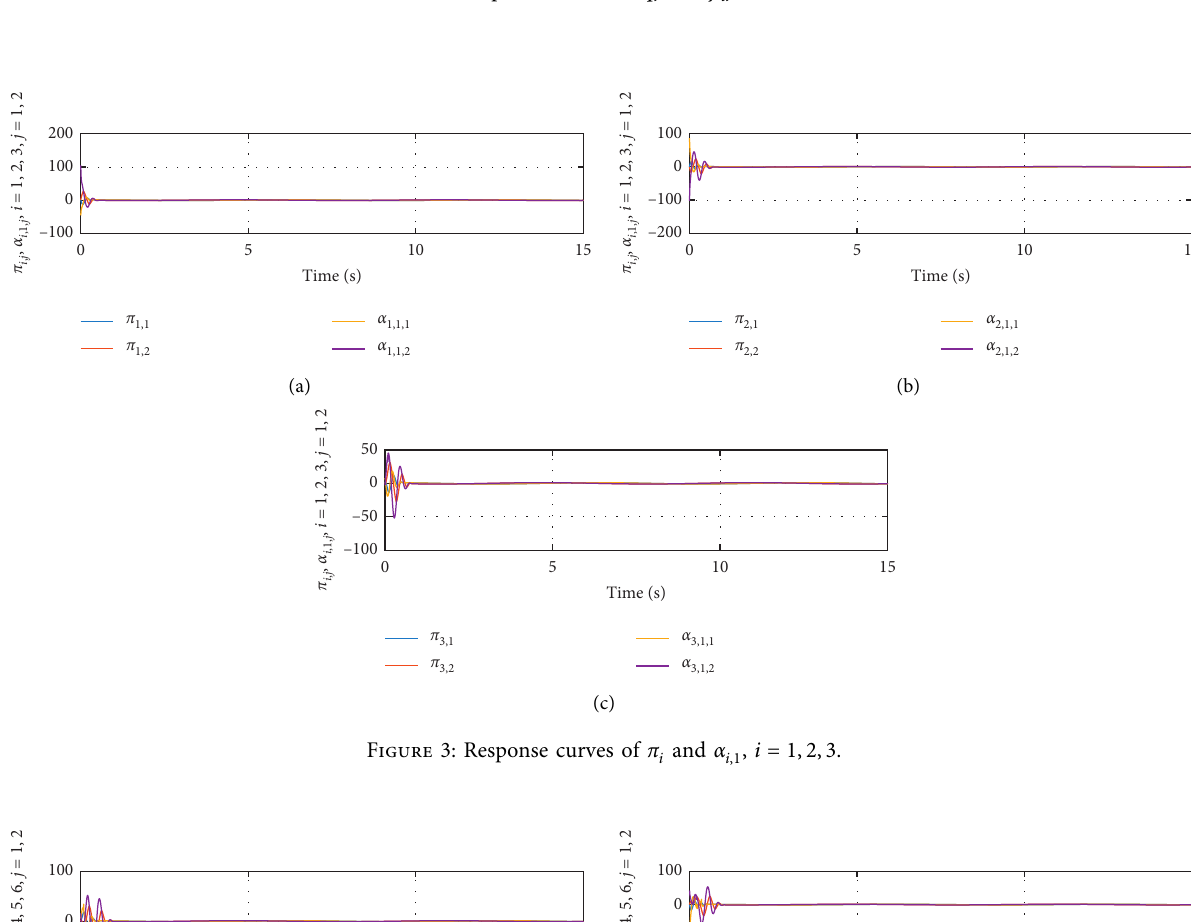
Figure 2: Response curves of q